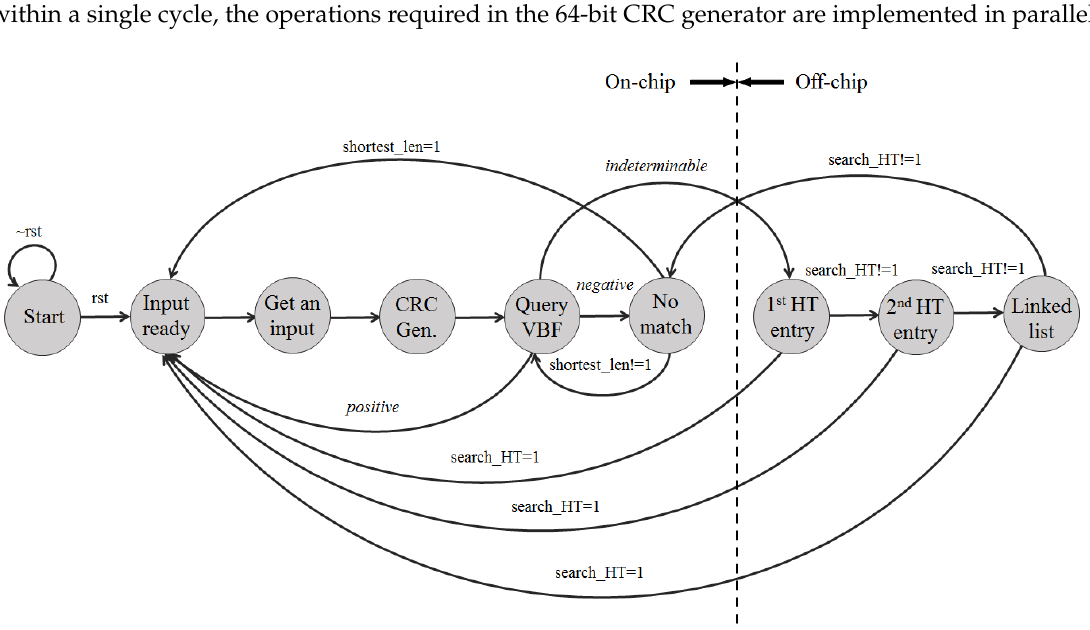
Figure 3. State machine for Internet Protocol (IP) address lookup